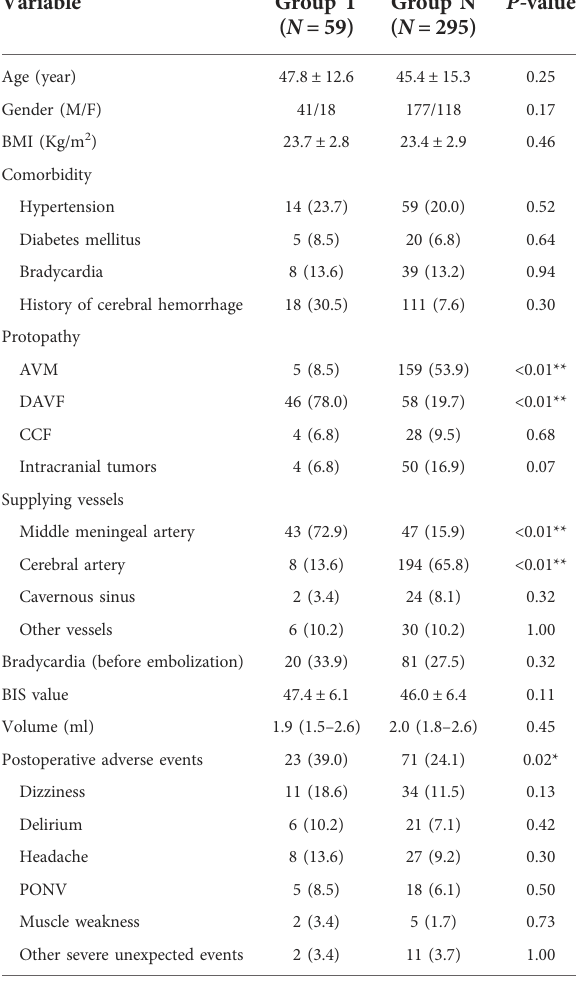
TABLE 1 Characteristics of patients exhibiting with or without TCR.